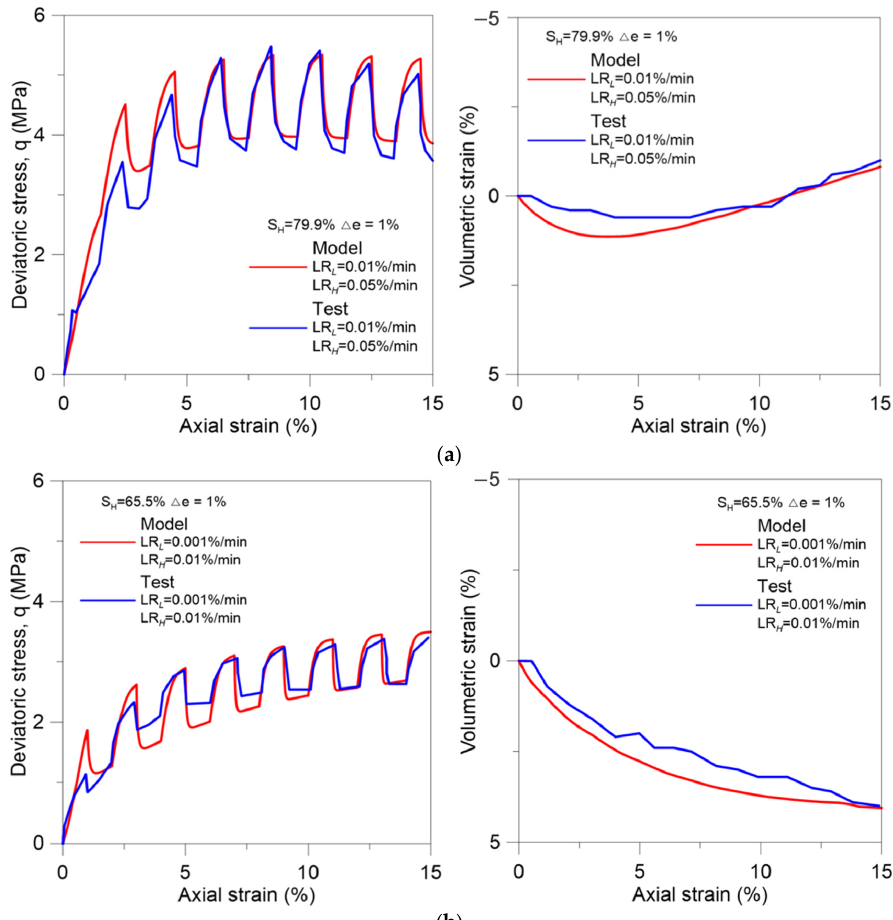
Figure 14. Case 3 considering effect of loading rate on MHBS behavior Yoneda et al. [41]. ( a ) ‘Spec- imen one’ from Borehole 16B-4P; ( b ) ‘Specimen two’ from Borehole 17C-9P. ( a ) ‘Specimen one’ from Borehole 16B-4P; ( b ) ‘Specimen two’ from Borehole